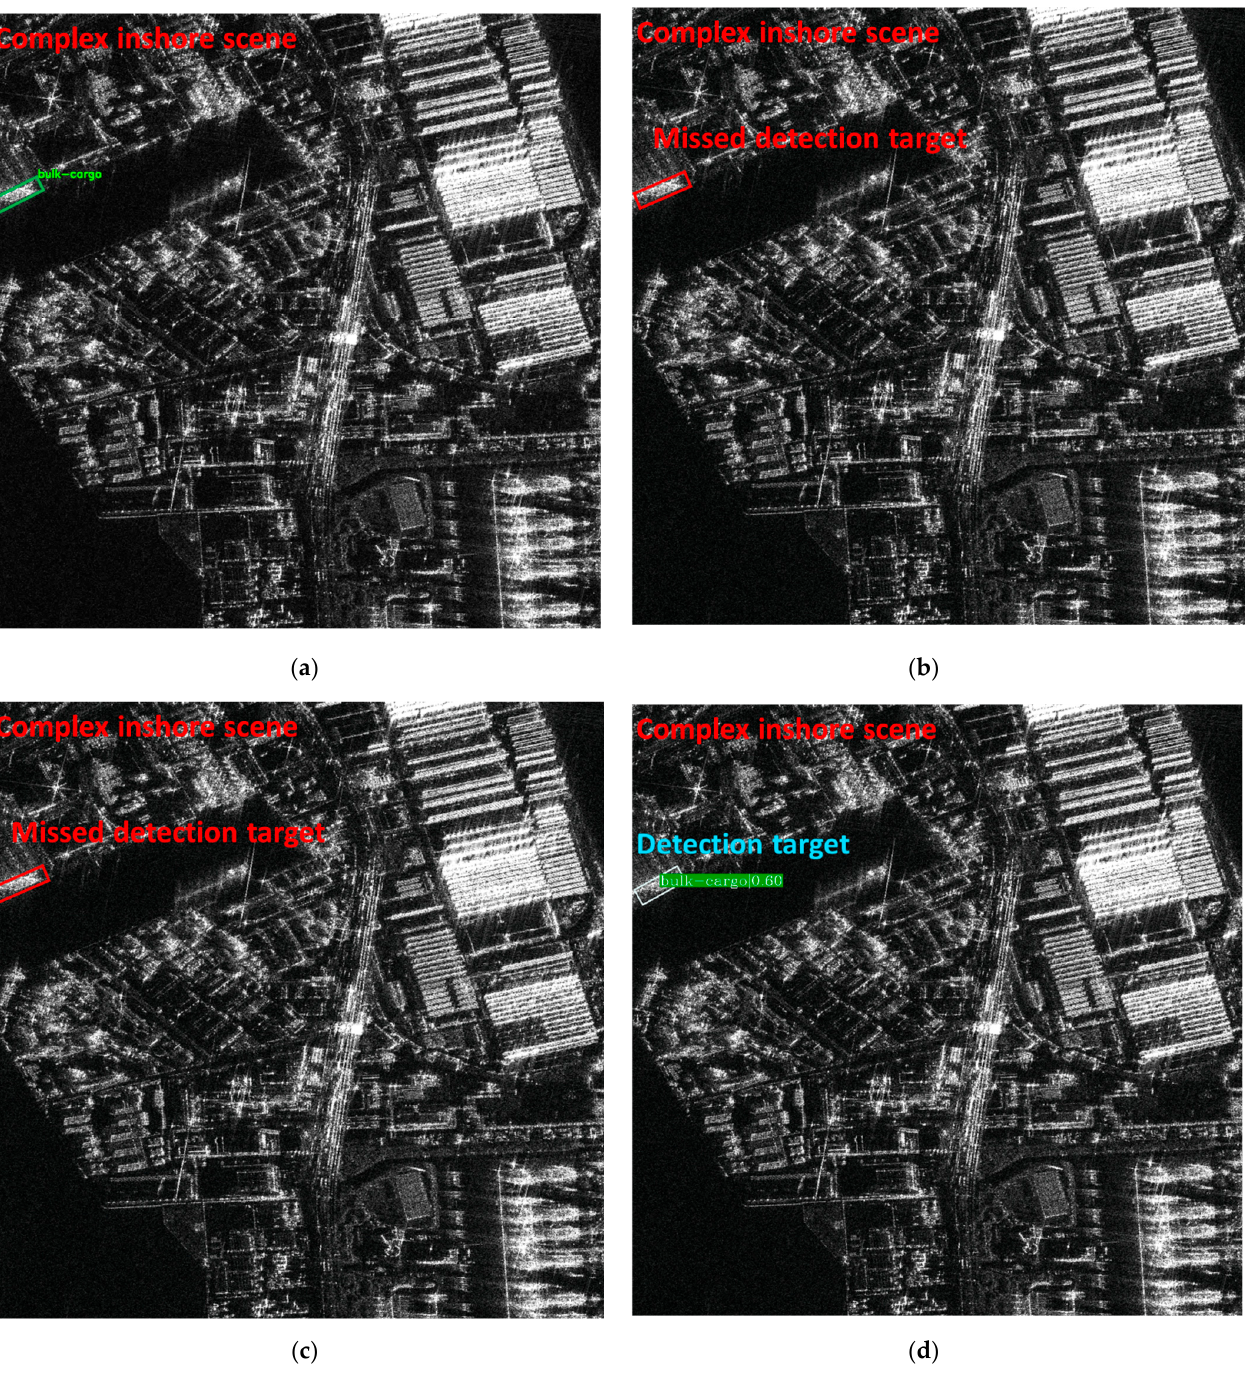
Figure 13. Detection results in inshore scenes. ( a ) Ground truth; ( b ) Result of ROI; ( c ) Result of O-RCNN; ( d ) Result of RBFA-Net.